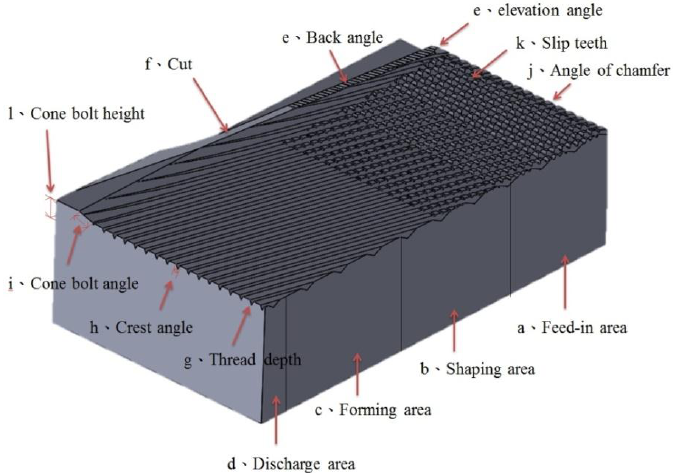
Figure 4. Parts of a thread plate.